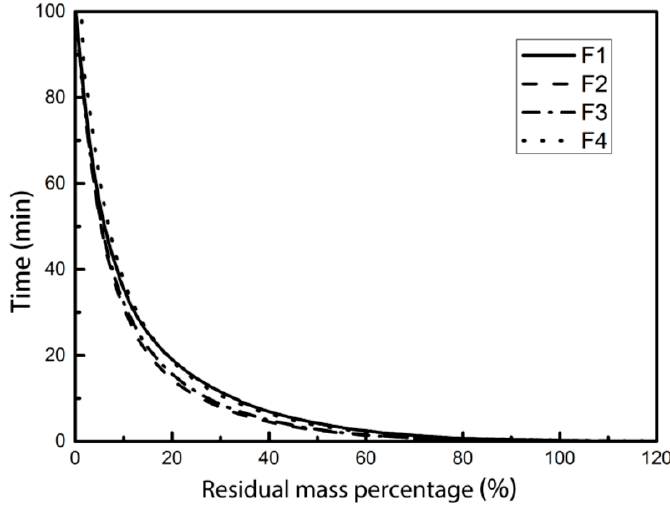
Figure 9. Comparison of TG curves of nascent soot particles under different conditions